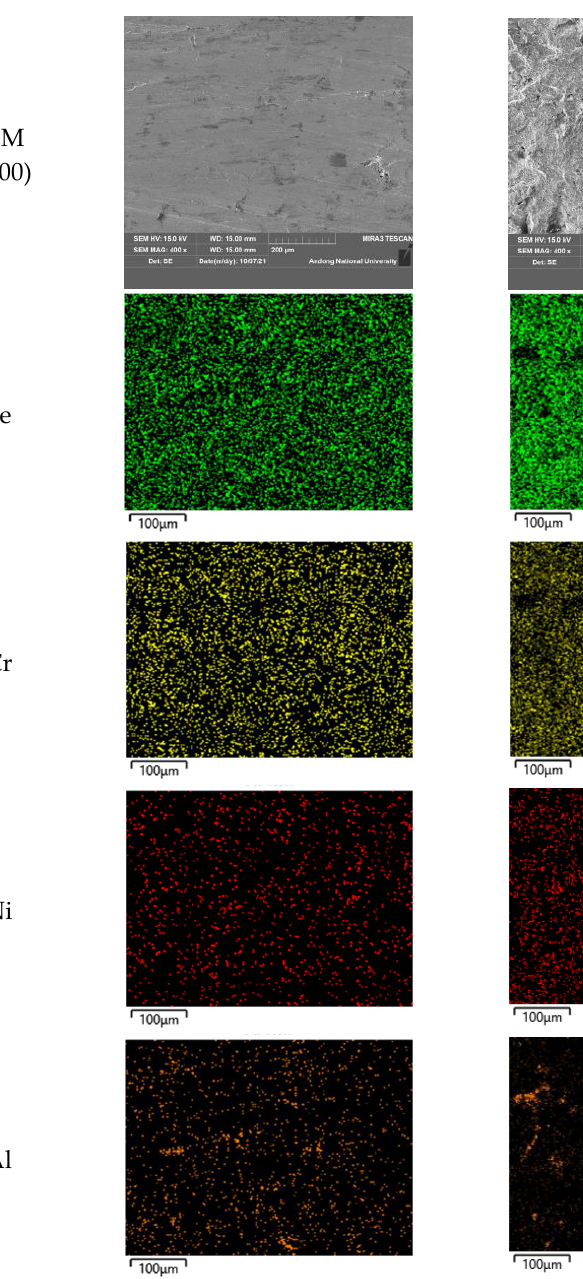
Figure 4. The surface appearance of 304L stainless steel after LP; ( a ) 304L(nonpeened), ( b ) 304L-L- NC (laser-peened without Al coating), and ( c ) 304L-L-WC (laser-peened with Al coating).